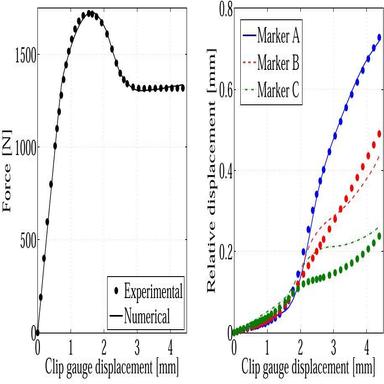
Mechanical response using VTM model for the best fitting of force f F .